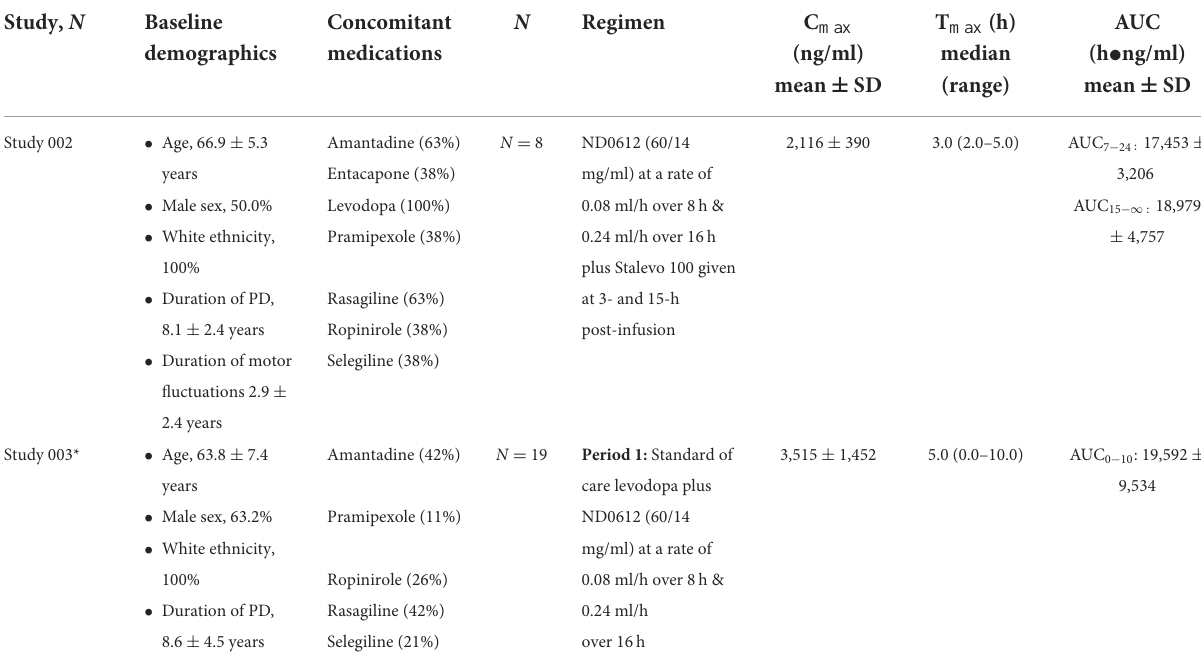
TABLE 2 ND0612 levodopa pharmacokinetics in patients with Parkinson’s disease. Study, N Baseline Concomitant demographics